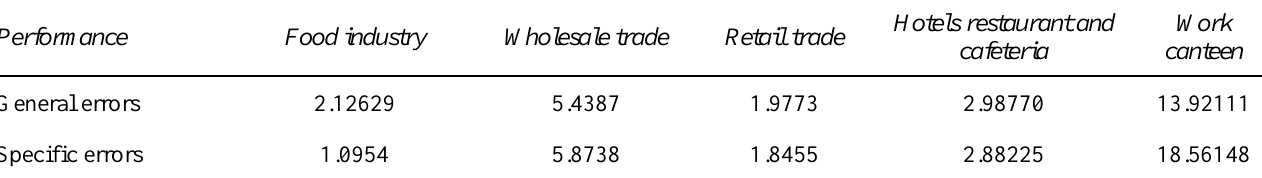
Table 8: Performance general errors and specific